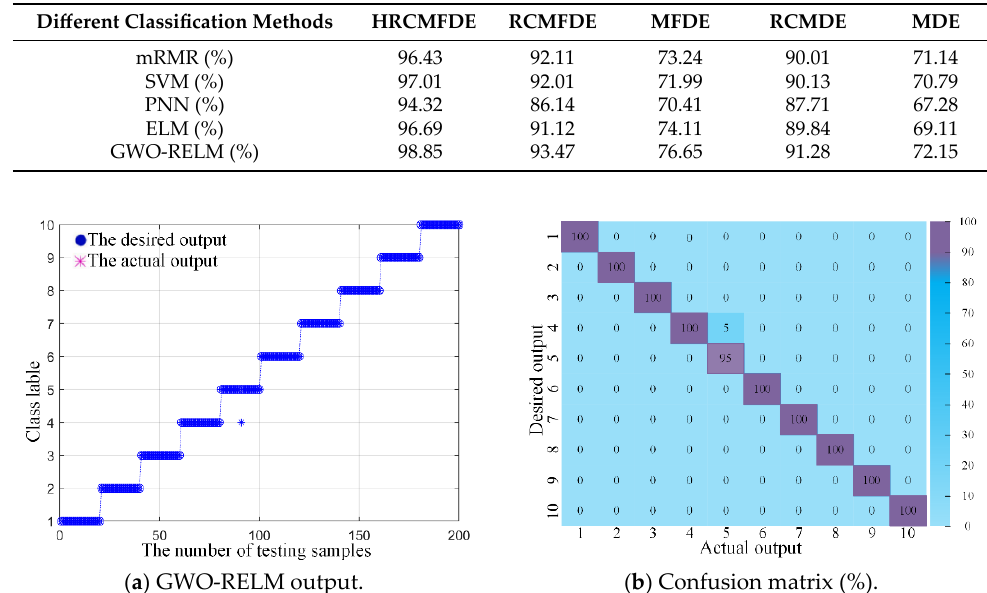
Table 10. Comparison of models under different classification methods.